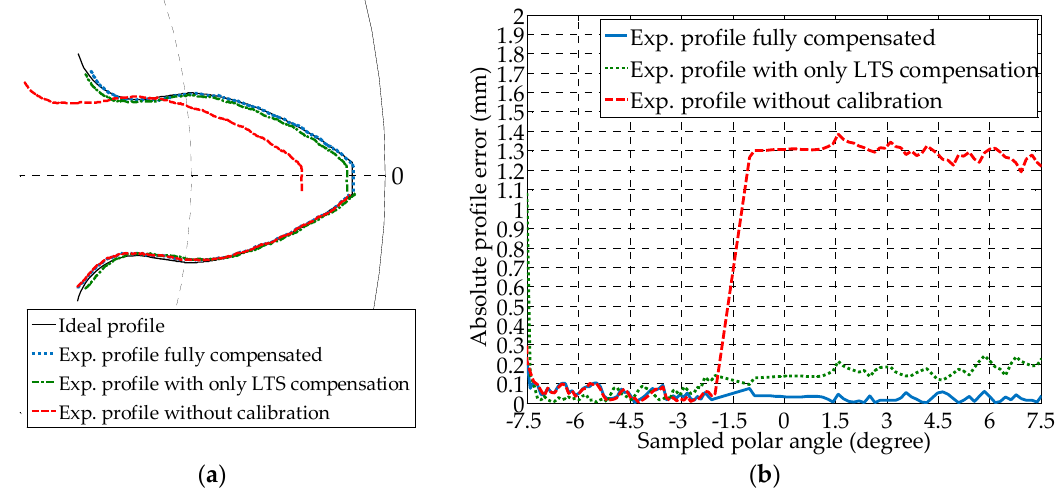
Figure 9. Error comparison between the calibrated gear profile result at x 1 = 35 mm, with only LTS compensation, full calibration with mounting error compensated based on homogeneous transformation, and the uncalibrated result: ( a ) Comparison of reconstructed tooth profiles; and ( b ) Comparison of profile error with respect to the ideal profile.